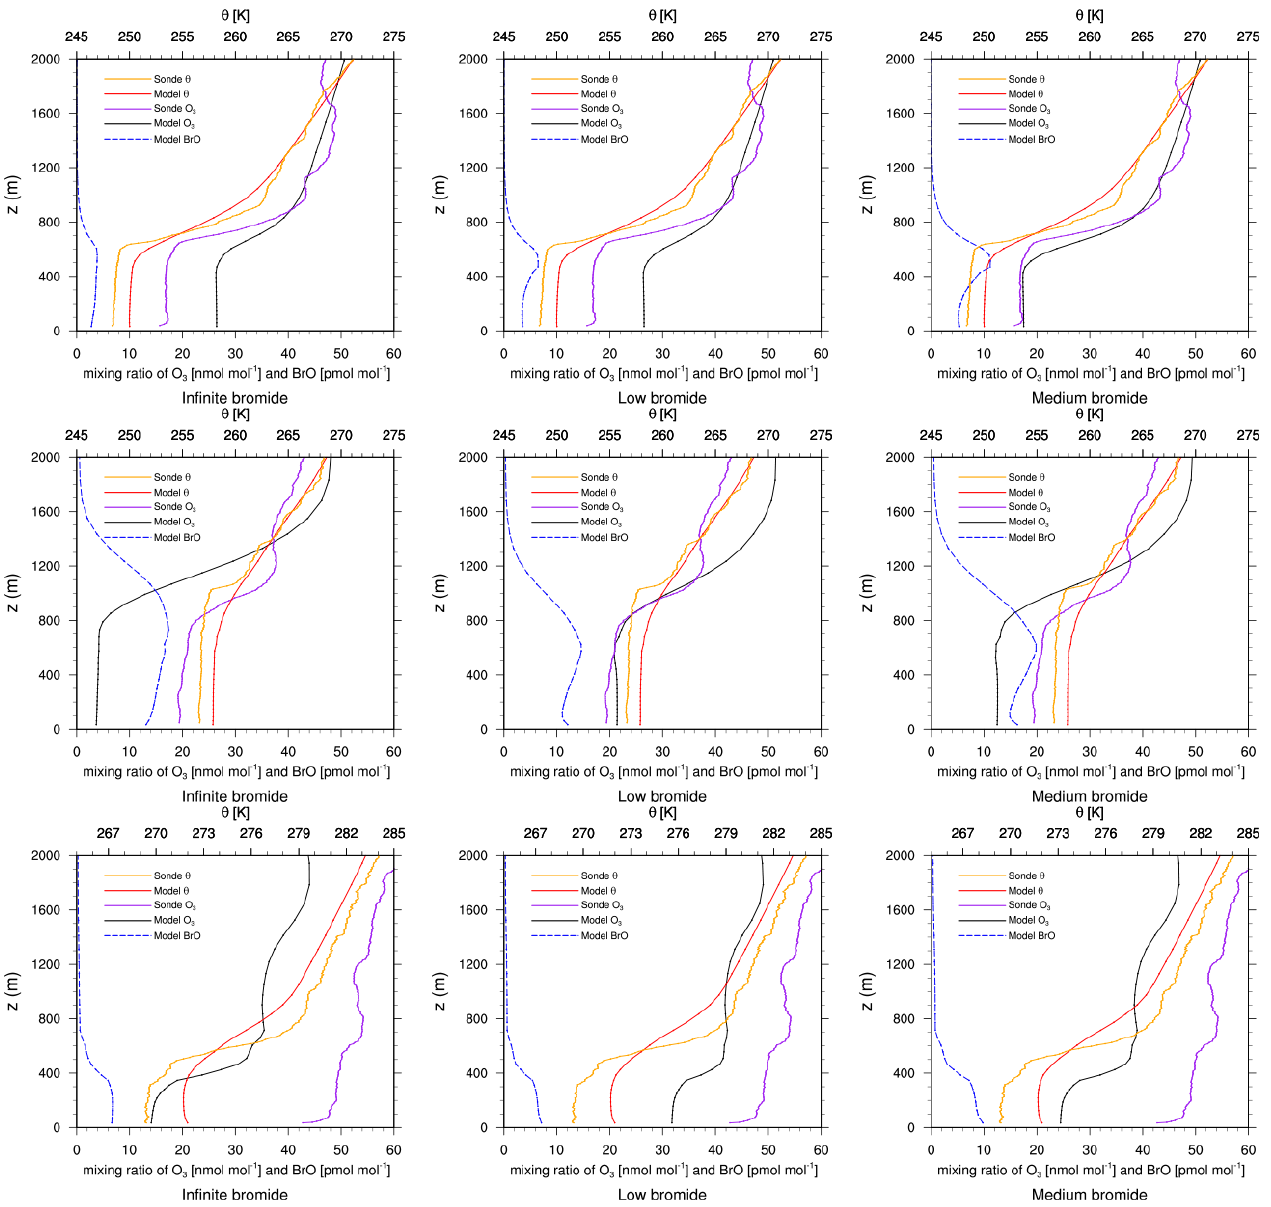
Figure 5. Modeled BrO mixing ratio as well as potential temperature θ and ozone mixing ratios from simulations and from ozone sonde flights against height at Churchill. Columns: infinite FY ice bromide (left), low bromide (center), medium bromide (right). Rows: 2 March 2019 (top), 3 April 2019 (center) 17 April 2019